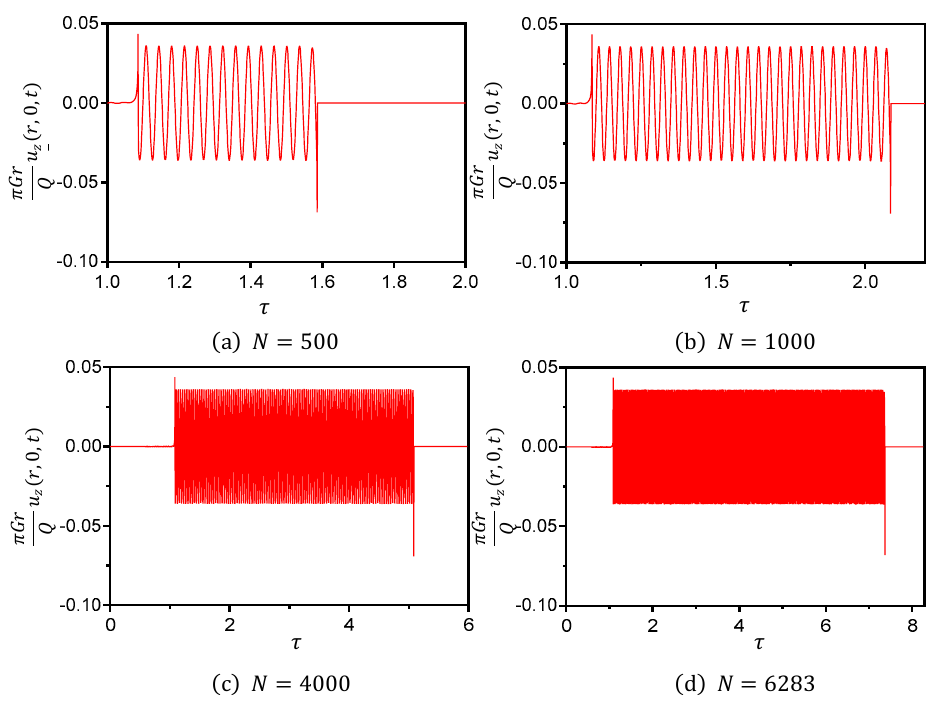
Figure 5. Change curve of vertical displacement at different times.